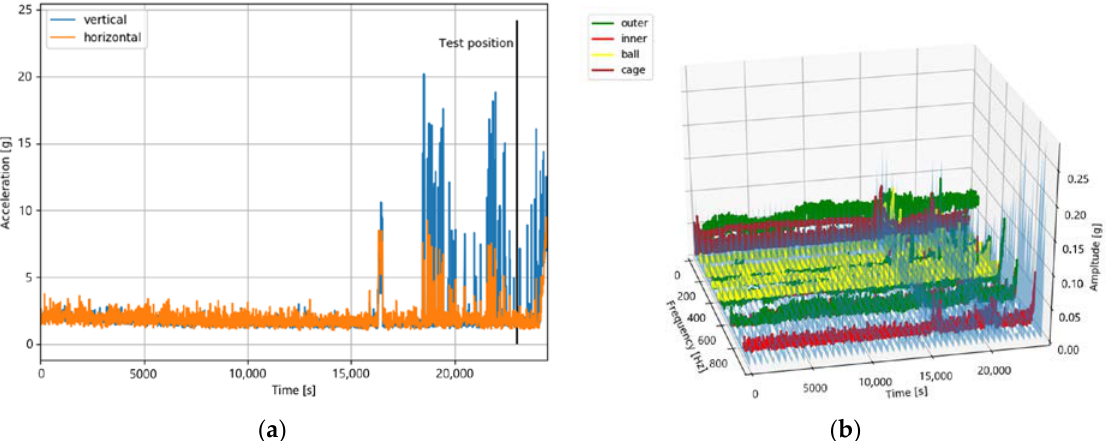
Figure 14. The sensor values of bearing dataset 1_6 in the time domain ( a ) and in the time–frequency domain ( b ). Both plots show no increased measured values at the test position after 23,020 s.